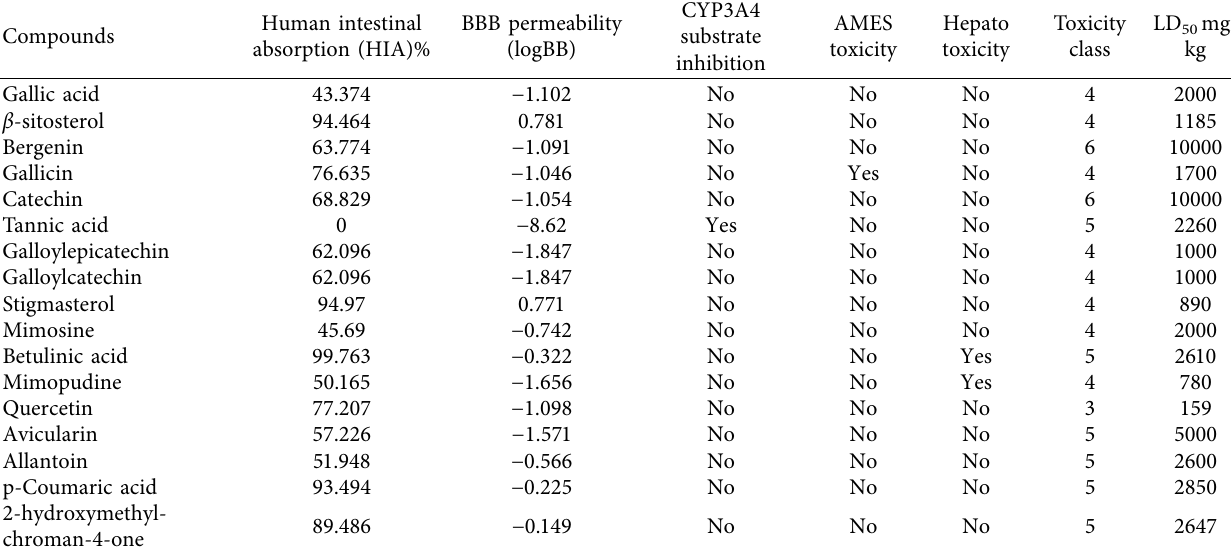
Table 4: Pharmacokinetic analysis of compounds isolated from B. ciliata and M. pudica .